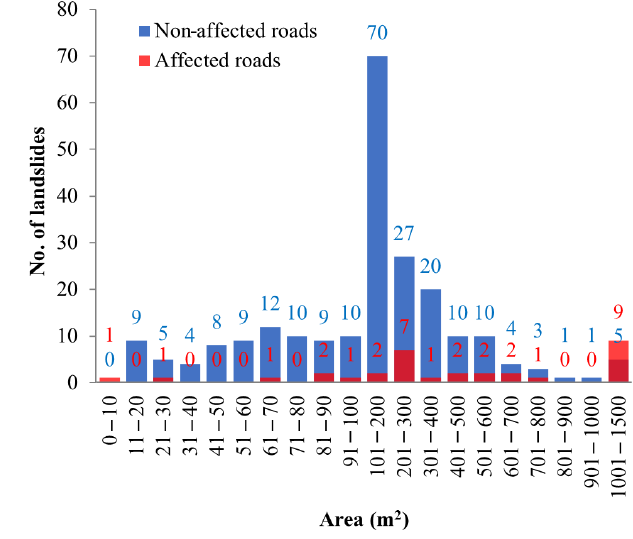
Figure 3. Landslide size frequency